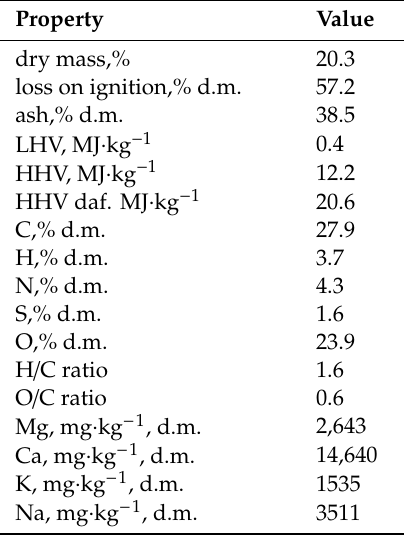
Table 1. Raw sewage sludge